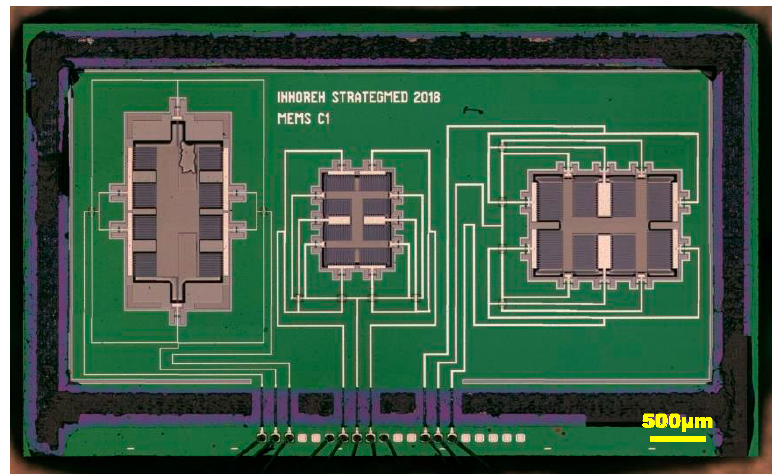
Figure 5. 3-axis MEMS accelerometer photography. ( right ) X-axis accelerometer, ( centre ) Y-axis accelerometer, ( left ) Z-axis accelerometer.